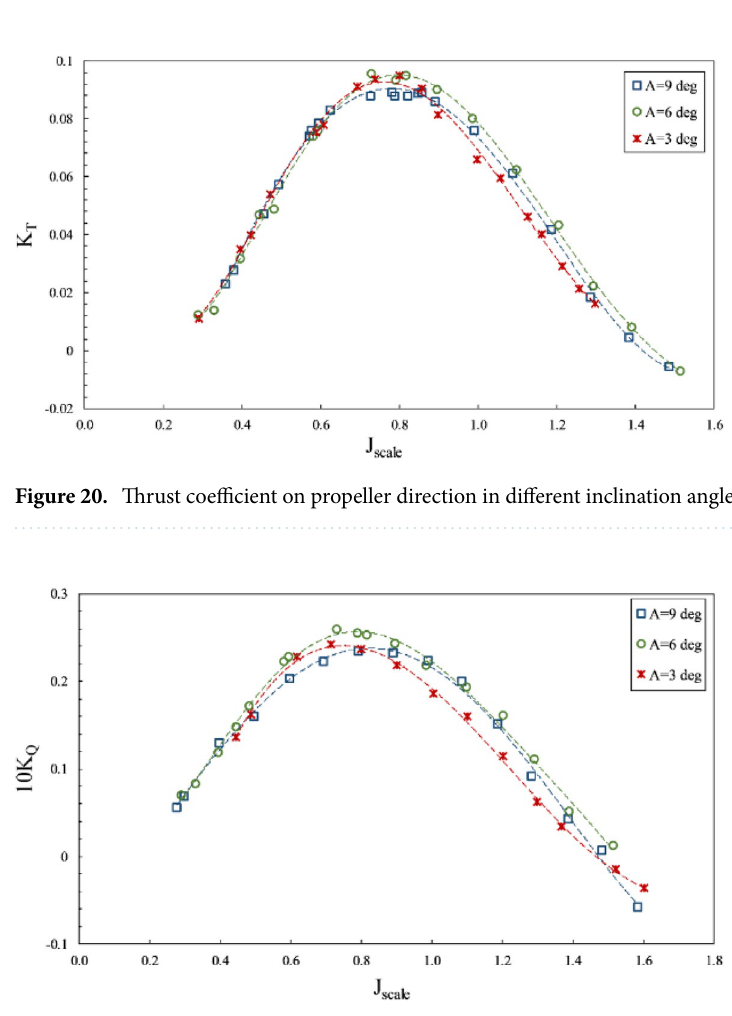
Figure 21. Torque coefficient on propeller direction in different inclination angles ( I = 0.4 ).